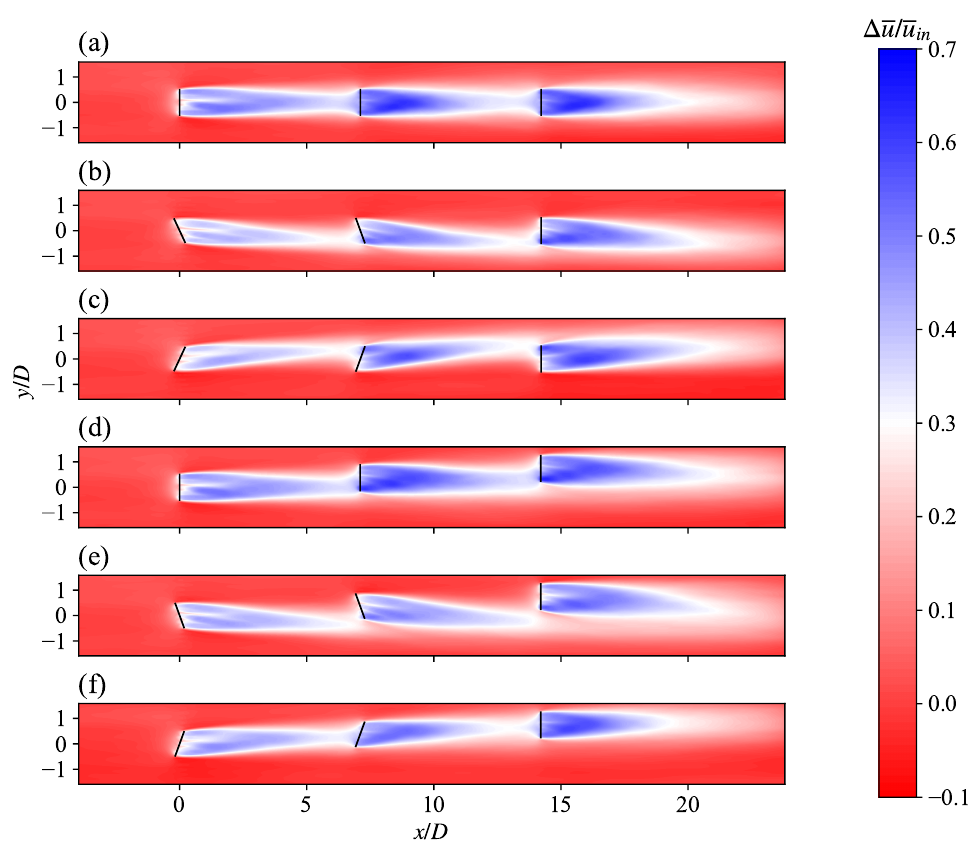
Figure 4. Top-view x - y cross-section contours of normalised streamwise mean velocity deficits ∆ u / u in at the hub height. Full-wake configuration ( α = 0 ◦ ): ( a ) γ = ( 0 ◦ ,0 ◦ ,0 ◦ ) ; ( b ) γ = ( 25 ◦ ,20 ◦ ,0 ◦ ) ; and ( c ) γ = ( − 25 ◦ , − 20 ◦ ,0 ◦ ) . Partial-wake configuration ( α = 3 ◦ ): ( d ) γ = ( 0 ◦ ,0 ◦ ,0 ◦ ) ; ( e ) γ = ( 25 ◦ ,20 ◦ ,0 ◦ ) ; and ( f ) γ = ( − 25 ◦ , − 20 ◦ ,0 ◦ )